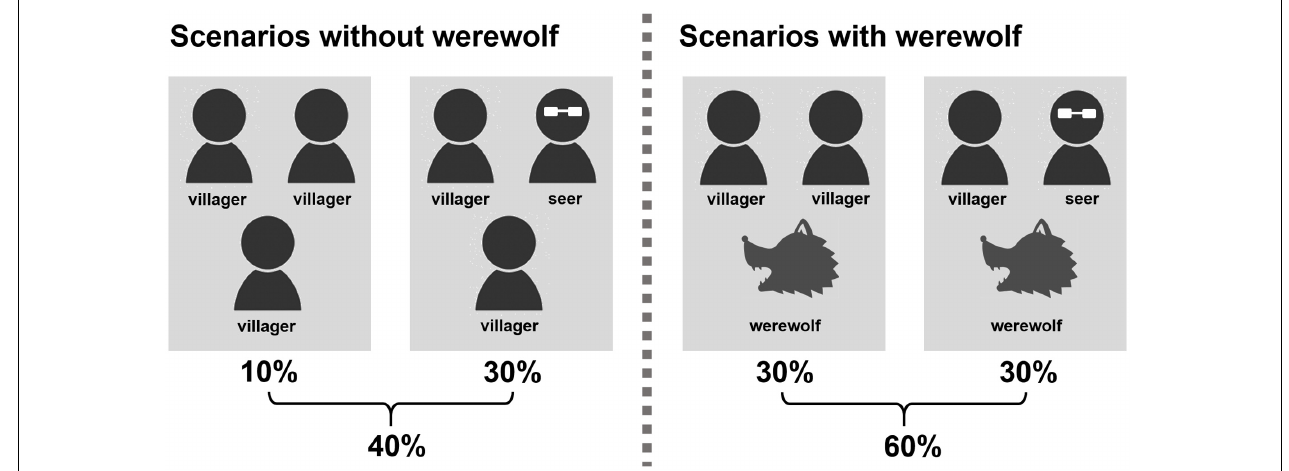
FIGURE 3 | Possible scenarios and probabilities of